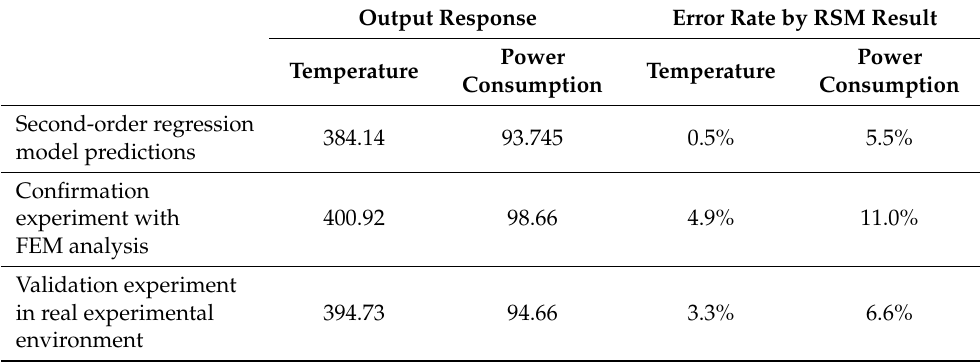
Table 12. A comparison of the temperature and power consumption values for the optimum cutting